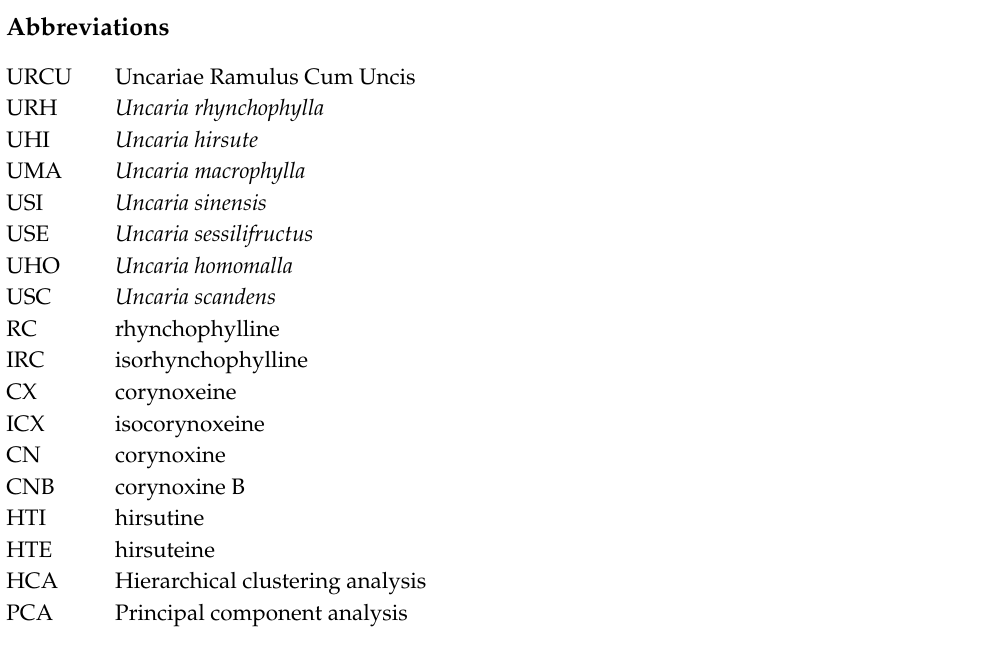
Figure S1: Intragenomic variation in the ITS2 sequences of Uncaria homomalla. The figure was performed by ClustalW-BOXSHADE alignment method. Black shade indicates identical base; white shade indicates variable base. Figure S2: The composition proportion of each targeted alkaloid in different Uncaria samples. Table S1: Main information of targeted alkaloids. Table S2: Method validation results of LC-MS/MS